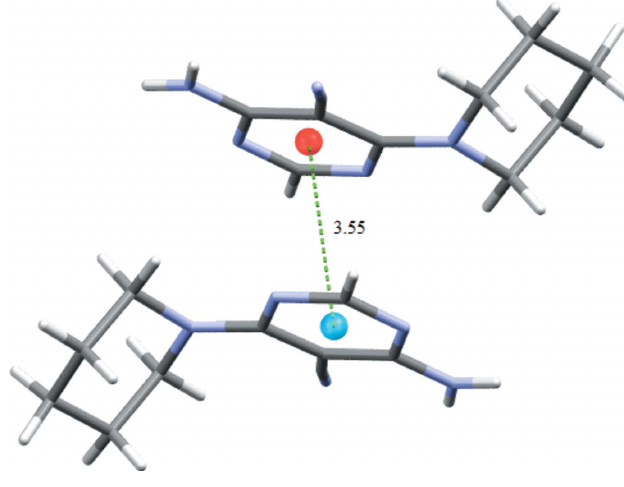
Figure 3 A fragment of the packing depicting the (cid:2) – (cid:2) interaction as a dashed line.